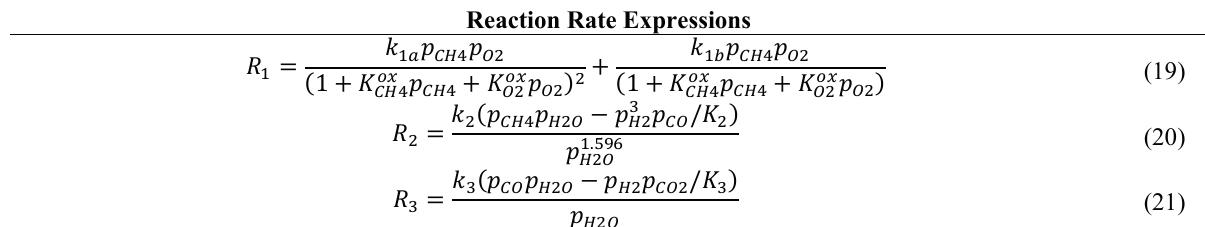
Reaction Rate Expressions